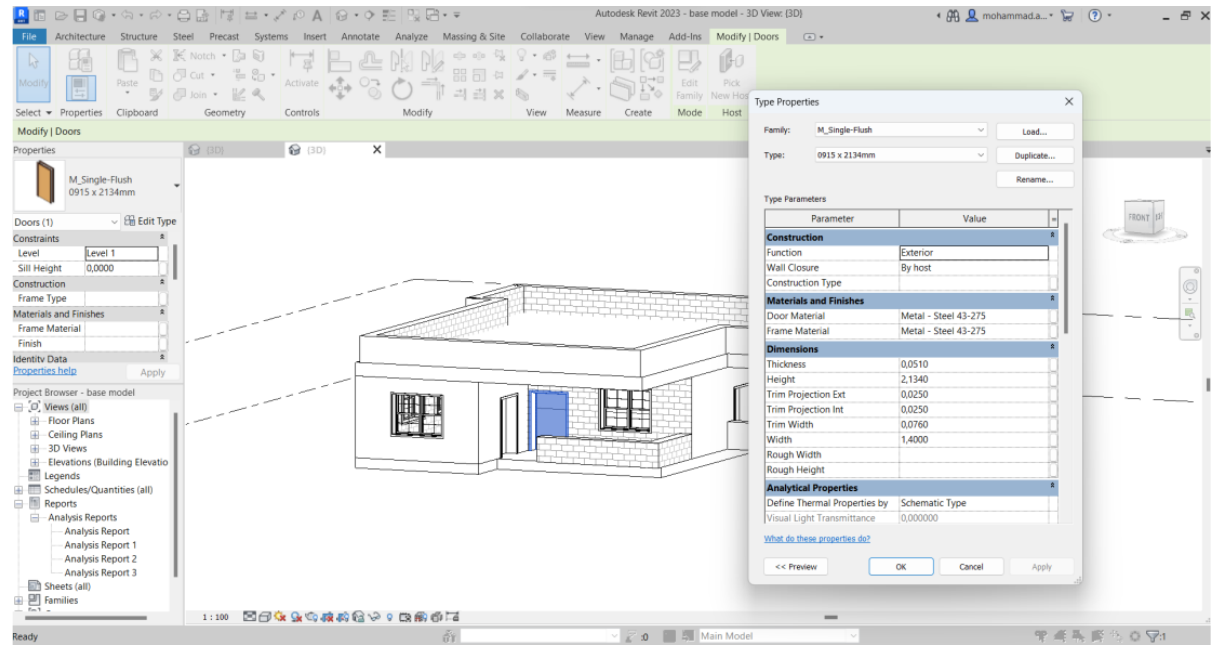
Figure A5. Doors ’ energy analytical properties (Case 1). Figure A5. Doors’ energy analytical properties (Case